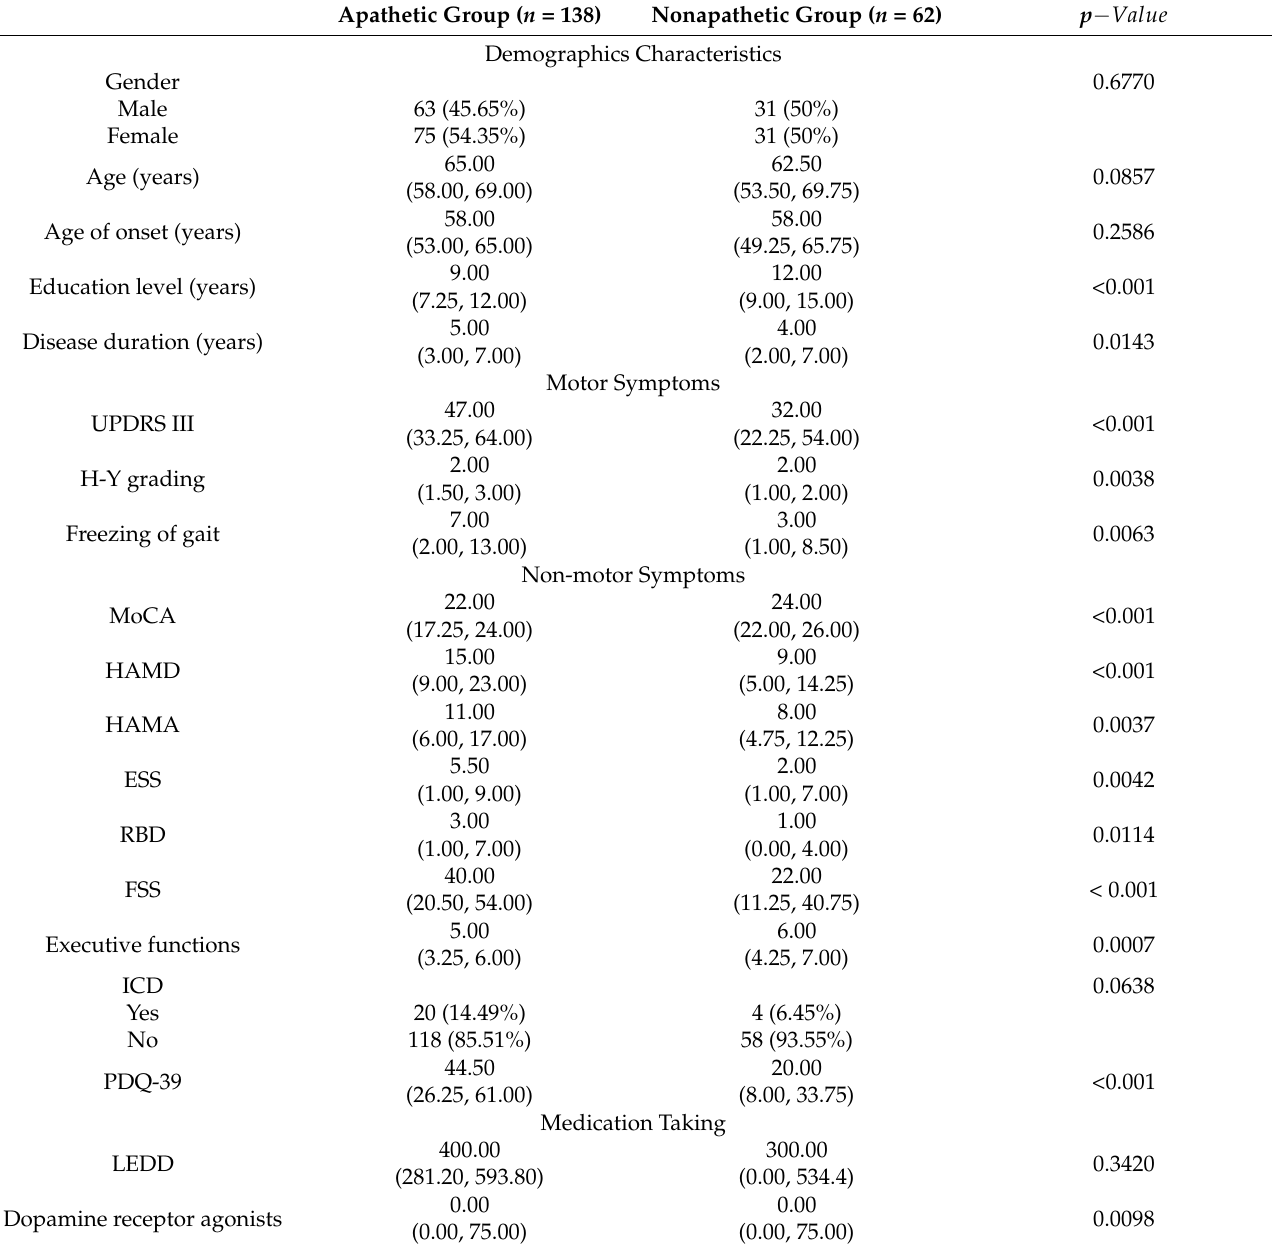
Table 1. Univariate Analysis: Comparison of apathetic and nonapathetic